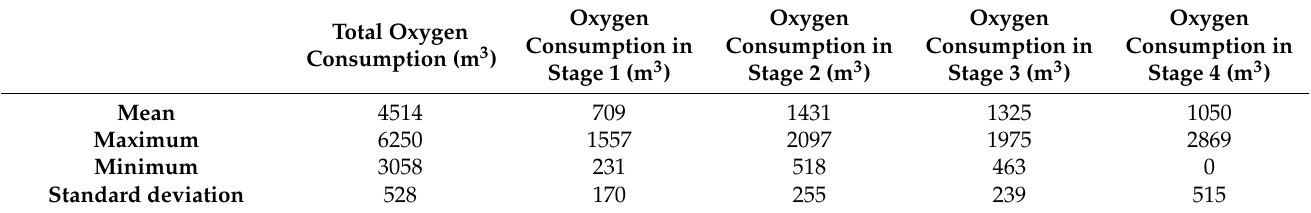
Table 4. Characteristic statistics of oxygen supply in different stages of 400 heats.